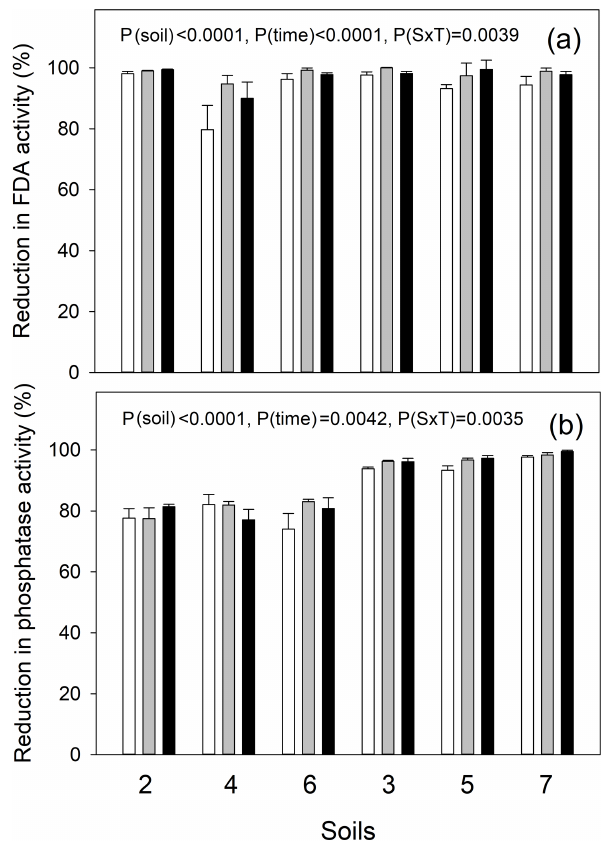
Figure 3. Response of soil enzyme activities to autoclaving: per- centage inhibition of (a) fluorescein diacetate (FDA) hydrolysis as a proxy for the inhibition of live, cell-bound microbial enzyme ac- tivity and of (b) MUF-phosphomonoesterase activity as a proxy for the inhibition of extracellular enzyme activity. Temperate grassland soils (2, 4 and 6) and tropical forest soils (3, 5 and 7) were tested. A two-way ANOVA was carried out to test for the factors soil, time (1, 24 and 48h after second autoclaving cycle, in open, gray and black bars, respectively) and their interaction. P values are